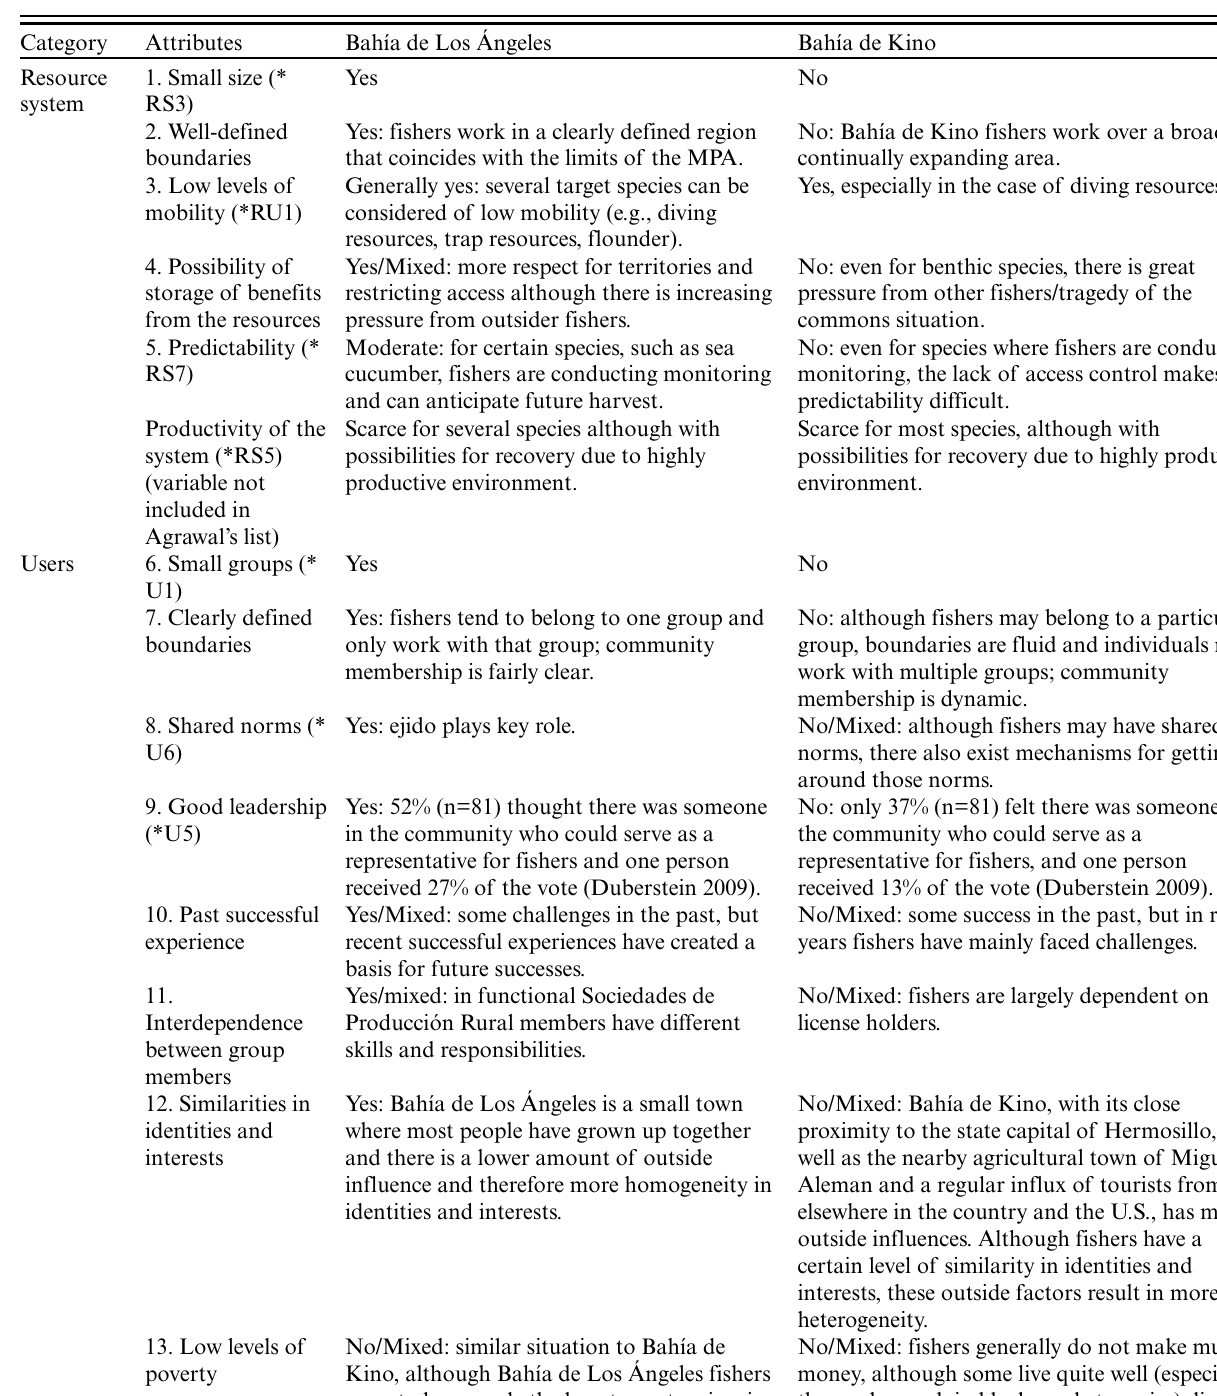
Table 4 . Critical enabling conditions for sustainability on the commons (after Agrawal 2001) and institutional emergence (marked with asterisks, indicating the corresponding variable of the SES framework) (after Ostrom 2007) applied to Bahía de Los Ángeles' and Bahía de Kino's small-scale